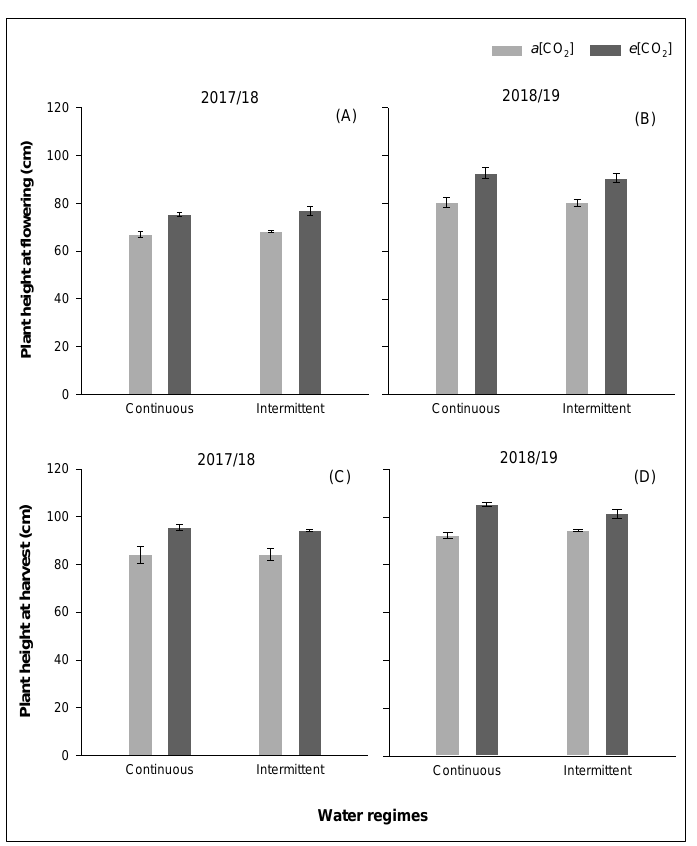
Figure 3. Effect of atmospheric CO 2 concentrations ( a [CO 2 ] = 400 μmol mol −1 and e [CO 2 ] = 700 μmol mol −1 ) and water regimes (continuous vs. intermittent flood) on plant height at flowering ( A , B ) and plant height at harvest ( C , D ) in the two seasons growing (2017/18 and 2018/19). Error bars correspond to 95% confidence intervals.